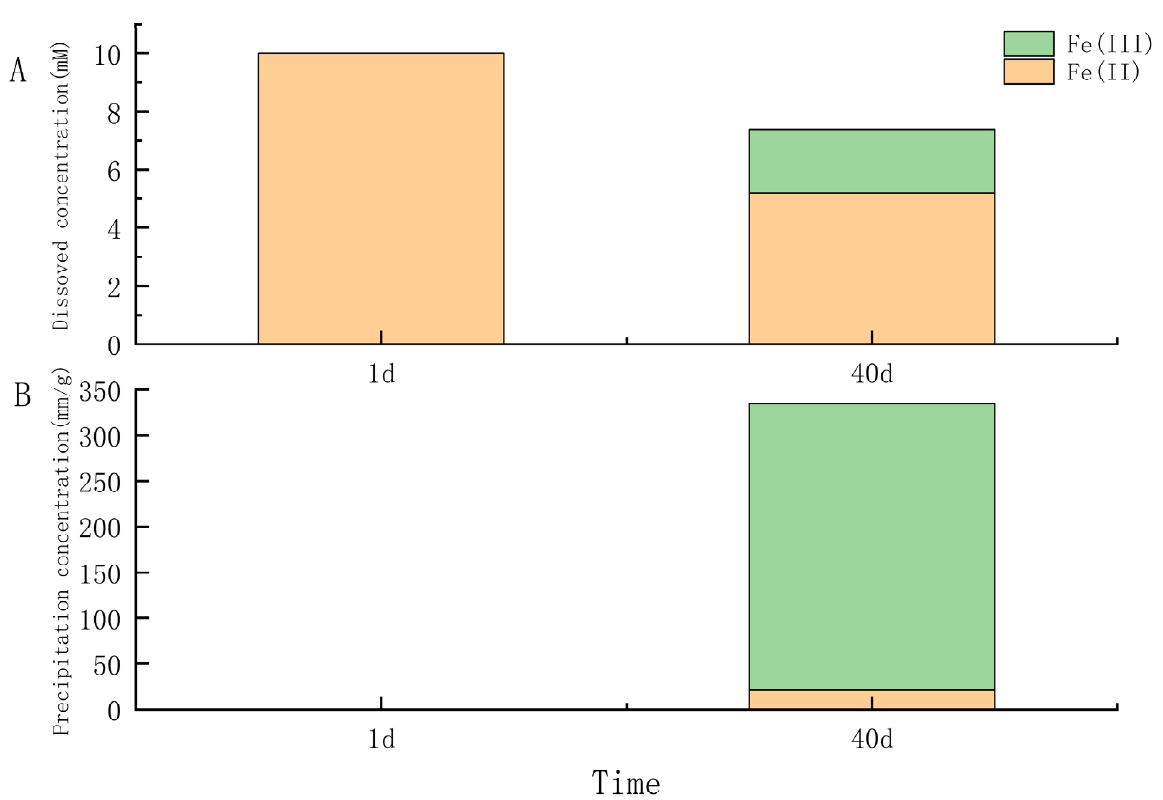
Figure 3. Fe(II) and nitrate consumption of Pseudomonas sp. IOP 13 in the presence of nitrate (10 mM) and ferrous iron over a period of 40 days. ( A ) Fe concentration in solution, ( B ) Fe concentration in precipitates.